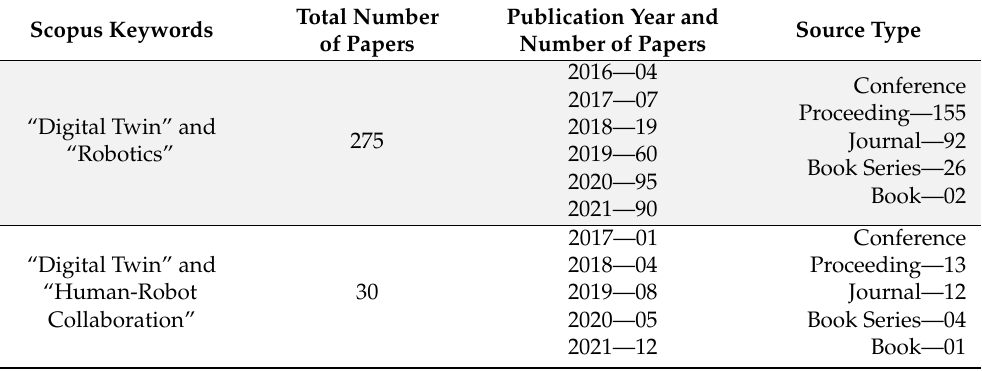
Table 1. Scopus indexed publications related to keywords “Digital Twin” & “Robotics”, and “Digital Twin”, & “Human-Robot Collaboration” in the domain of